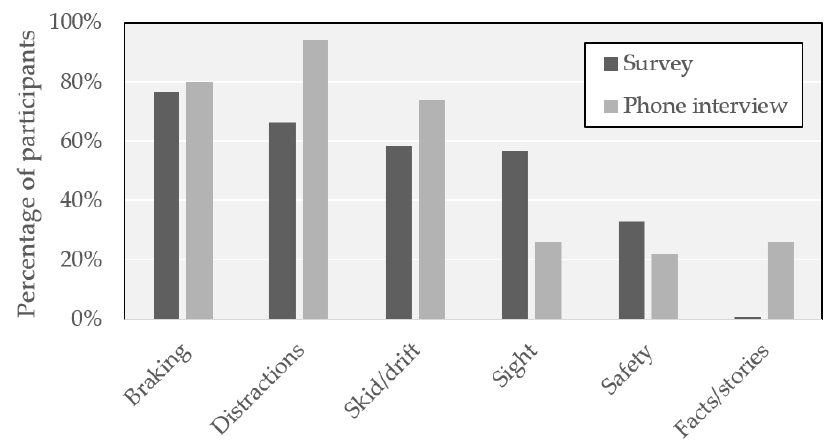
Figure 5. Topical areas for the top five things from the program: survey vs. phone interview.